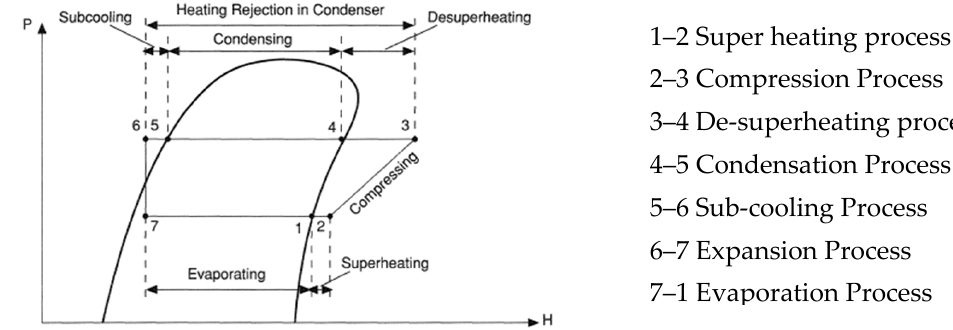
Figure 4. P-H diagram of a standard vapor-compression refrigeration system.